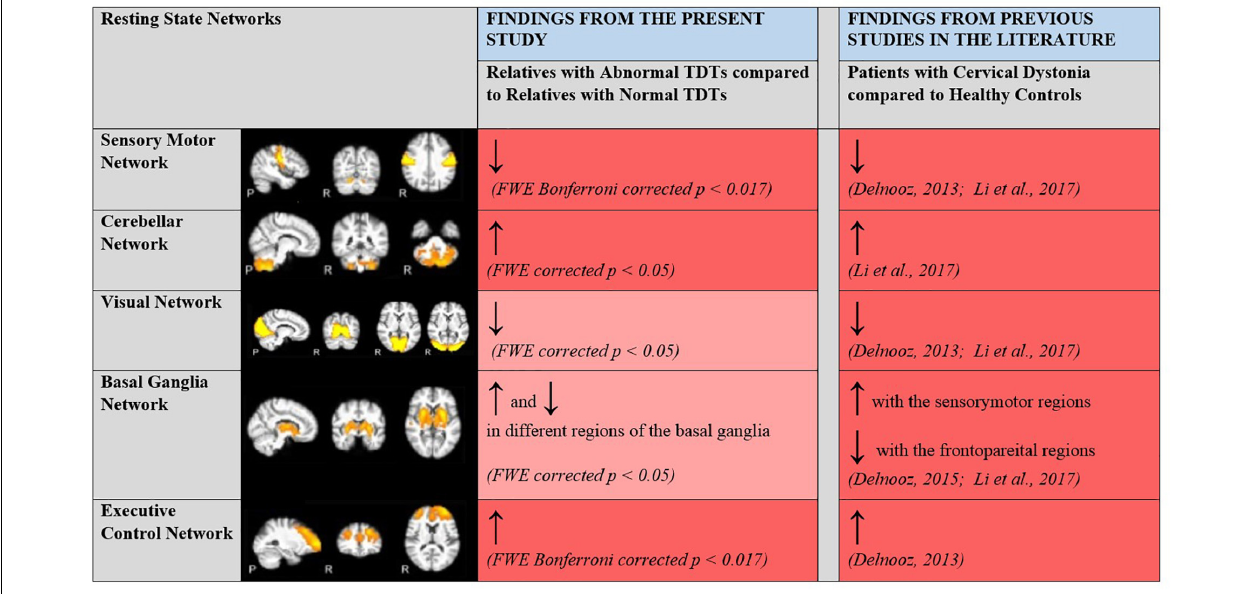
Frontiers in Integrative Neuroscience |